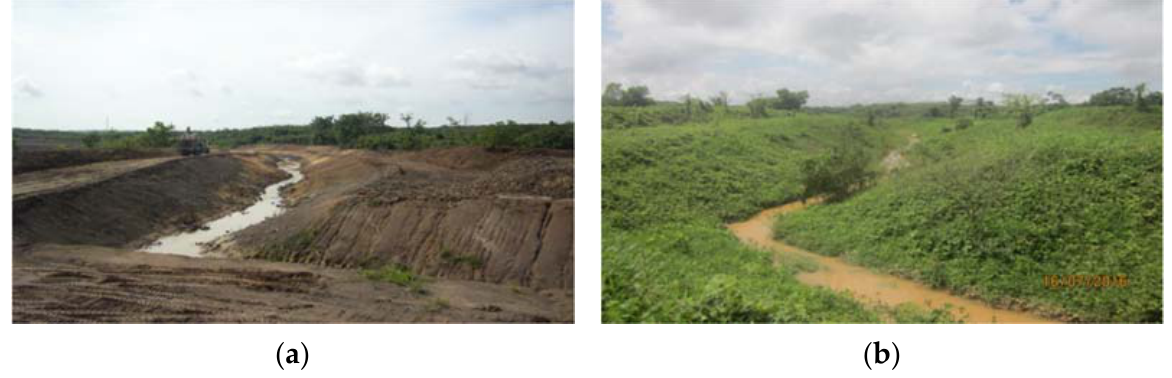
Figure 7. Post-coal mining before ( a ) and after ( b ) hydroseeding.